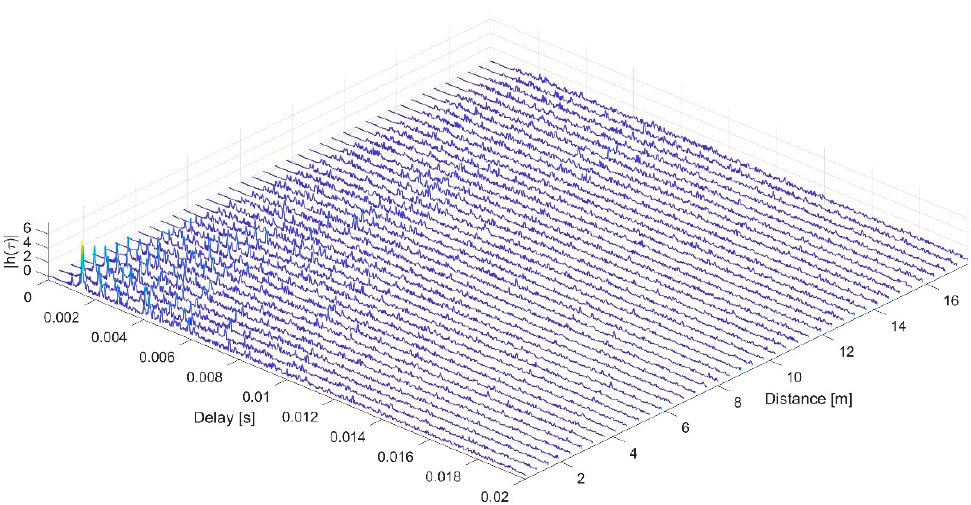
Figure 9. An example of changes in the modules of the impulse response estimates depending on the distance from the signal source for: F c = 60 kHz, v = 0.5 m/s, T = 60 ms, and B = 20